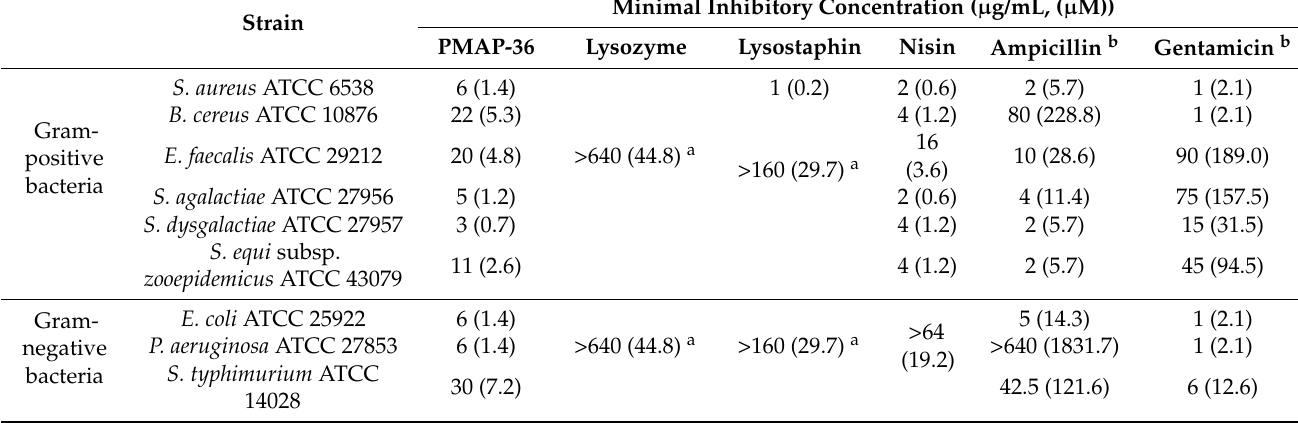
Table 2. Comparison of antimicrobial activities among lysozyme, lysostaphin, nisin, and PMAP-36 against bacterial strains examined in this